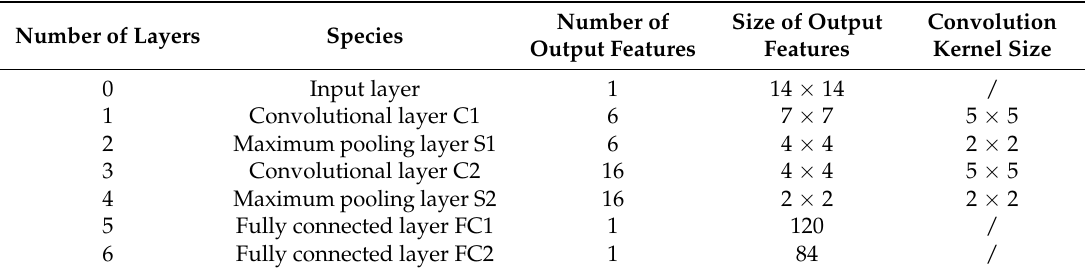
Table 3. Traditional CNN parameter table.